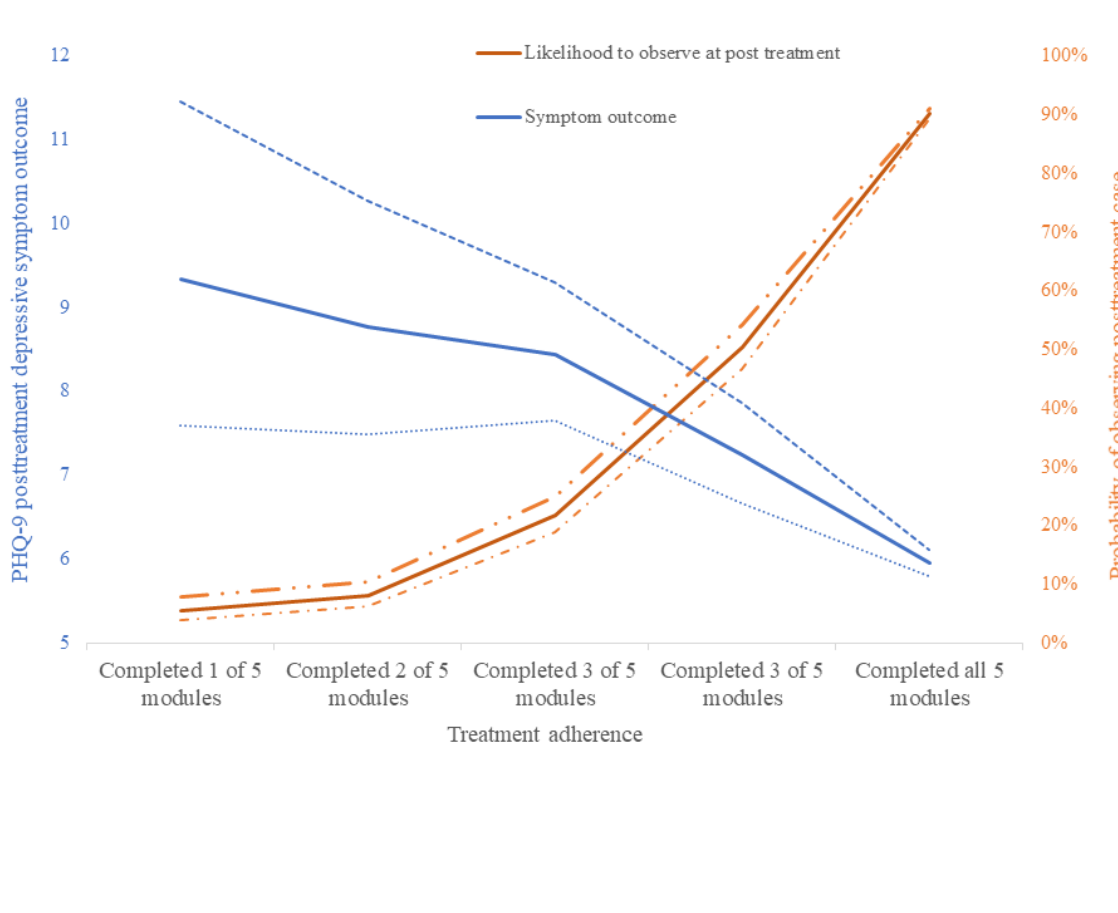
Figure 1. Probability for observing cases at posttreatment (inverse probability of missing cases) and treatment outcome trends associated with treatment completion; 95% CI is drawn around each effect in dotted lines. PHQ-9: Patient Health